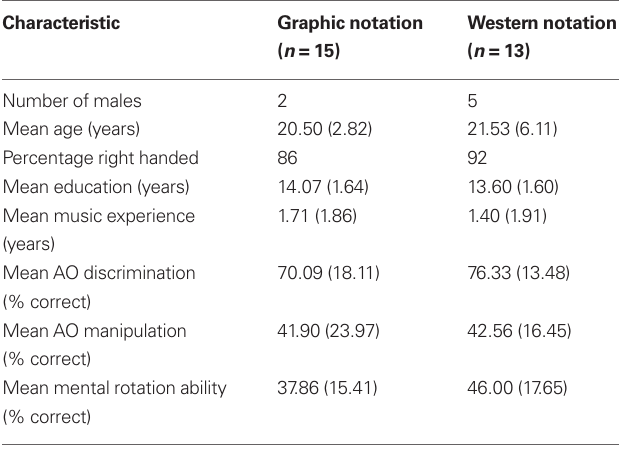
Table 4 | Demographic and baseline characteristics of the groups in experiment 1 ( ±